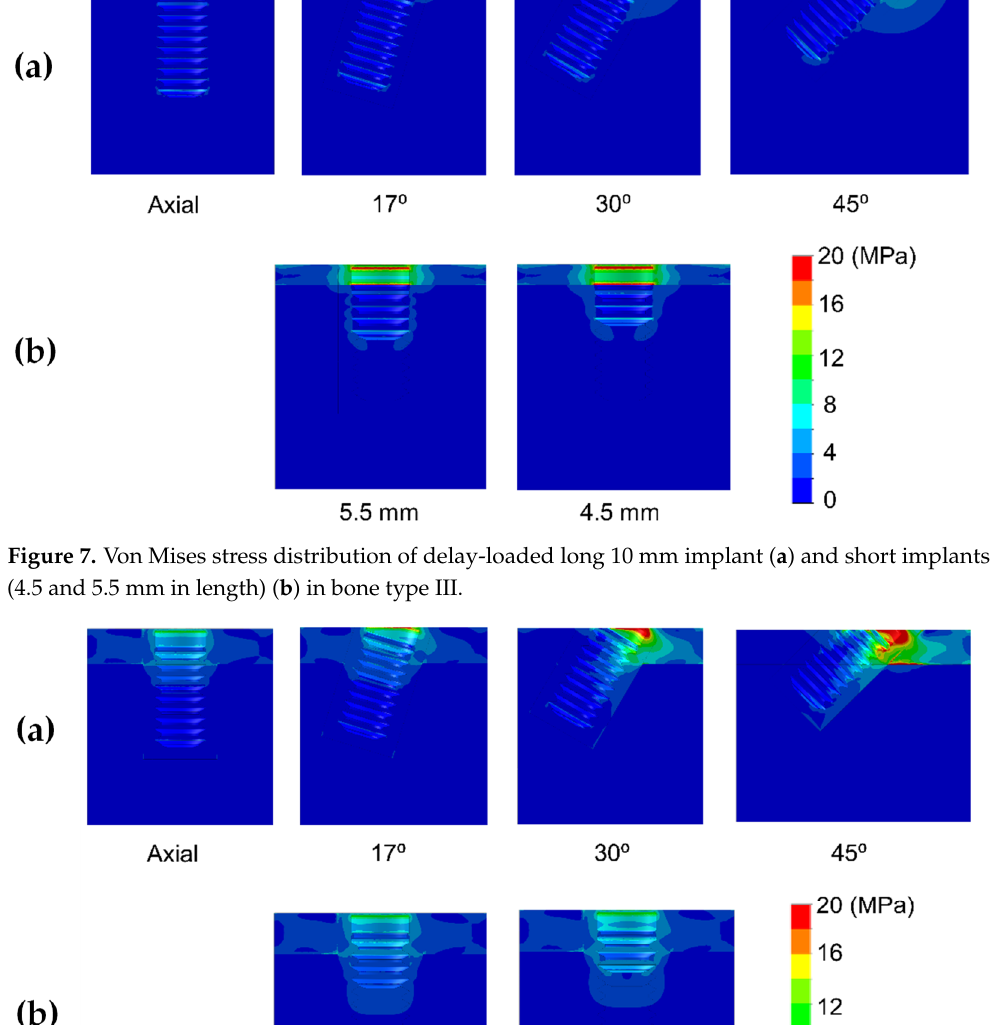
Figure 9. Von Mises stress distribution of delay-loaded long 10 mm implant ( a ) and short implants (4.5 and 5.5 mm in length) ( b ) in bone type 0-I.